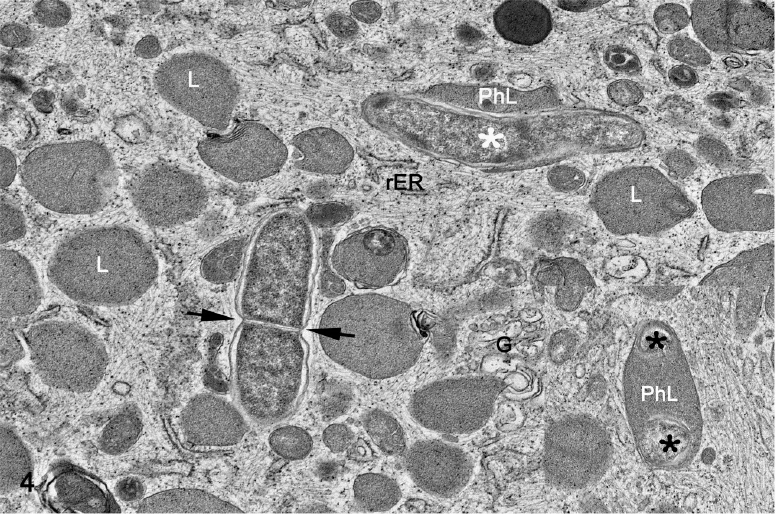
Fig 4. Monocyte-derived macrophage infected with Lawsonia intracellularis . Transmission electron microscopy. At 48 hours post infection, a sagittal section of a viable L . intracellularis organisms (white asterisks) is present within a phagolysosome (PhL). Free within the cytoplasm is a L . intracellularis organism in binary fission; black arrows show a formed wall separating the new two bacteria. G: Golgi apparatus; L: lysosome; rER: rough endoplasmic reticulum. Inset: cross section of viable L . intracellularis organisms (black asterisks) are present within a phagolysosome (PhL).